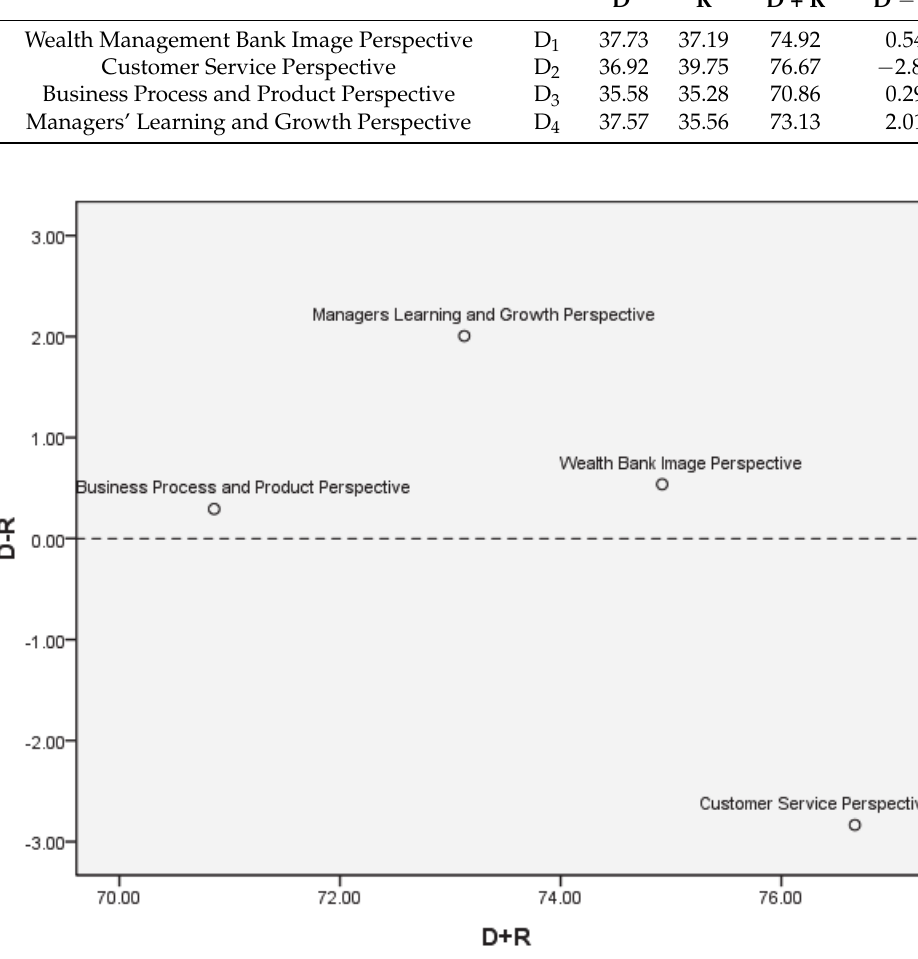
Figure 3. Causal diagram of the main evaluation dimensions .